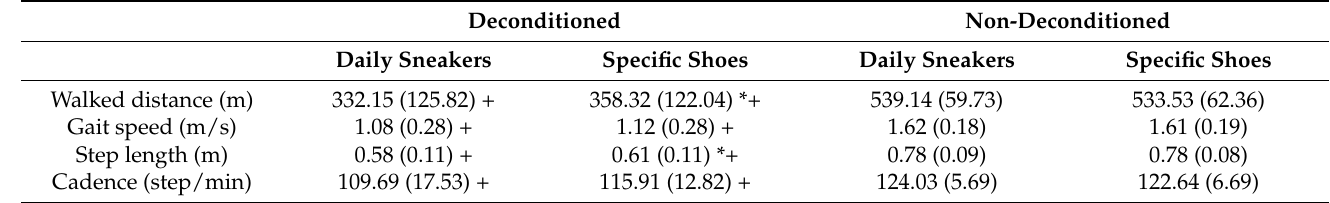
Table 3. Mean and standard deviation of i6MWT parameters of the two groups are reported for the two sessions (daily sneakers vs. specific shoes). * = p < 0.05, statistically significant in the post hoc comparison daily sneakers vs. specific-obesity shoes; + = p < 0.05, statistically significant in the post hoc comparison deconditioned vs. non-deconditioned group.